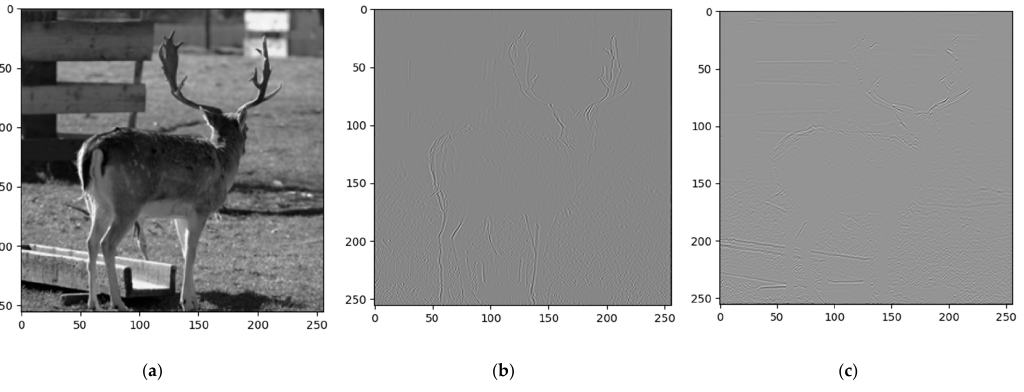
Figure 1. Filtering effect of Bank 7’s filters. ( a ) Grayscale image of 256 × 256 size. ( b ) Filtering effect of Bank 7’s base weight on the grayscale image after complementing zero. ( c ) Filtering effect of Bank 7’s base weight on the grayscale image after complementing zero and rotating 90° clockwise.